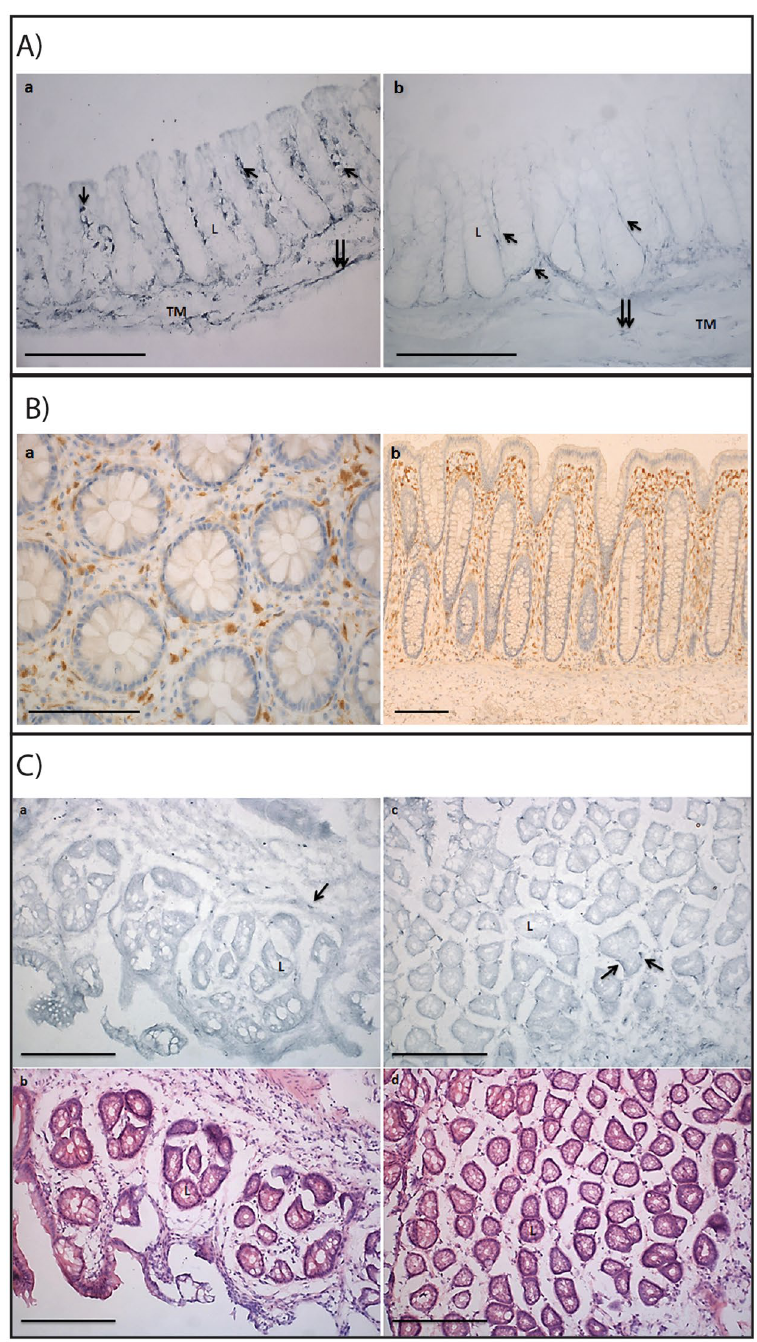
Figure 2. Cytoglobin protein expression in mouse and human colon. ( A ) Cygb-ir in healthy and inflamed C57BL/6 WT mouse colon tissue. (a) Longitudinal section of colonic crypts from untreated mice. (b) Longitudinal section of colonic crypts from week 7 AOM/DSS-treated mice. Single arrows indicate cells with Cygb-ir along Lieberkühn crypts. Double arrows indicate cells with Cygb-ir in tunica muscularis. L: Lieberkühn crypt, TM: tunica muscularis. 20x magnification, scale bars represent 200 µ m. ( B ) Cygb expression in normal human colon tissue with hematoxylin counterstaining. No Cygb-ir was observed in the crypts. (a) Cross section, 40x magnification b) Longitudinal section, 5x magnification. Scale bar represents 200 µ m. ( C ) Cygb-ir in AOM/ DSS-treated C57BL/6 WT mouse colon tissue. (a) Cygb-ir in inflamed area with adenoma. (b) H&E staining of area with adenoma. (c) Cygb-ir in inflamed area without adenoma. (d) H&E staining of area without adenoma. Arrows indicate cells with Cygb-ir. L: Lieberkühn crypt. 20x magnification, Scale bars represent 200 µ